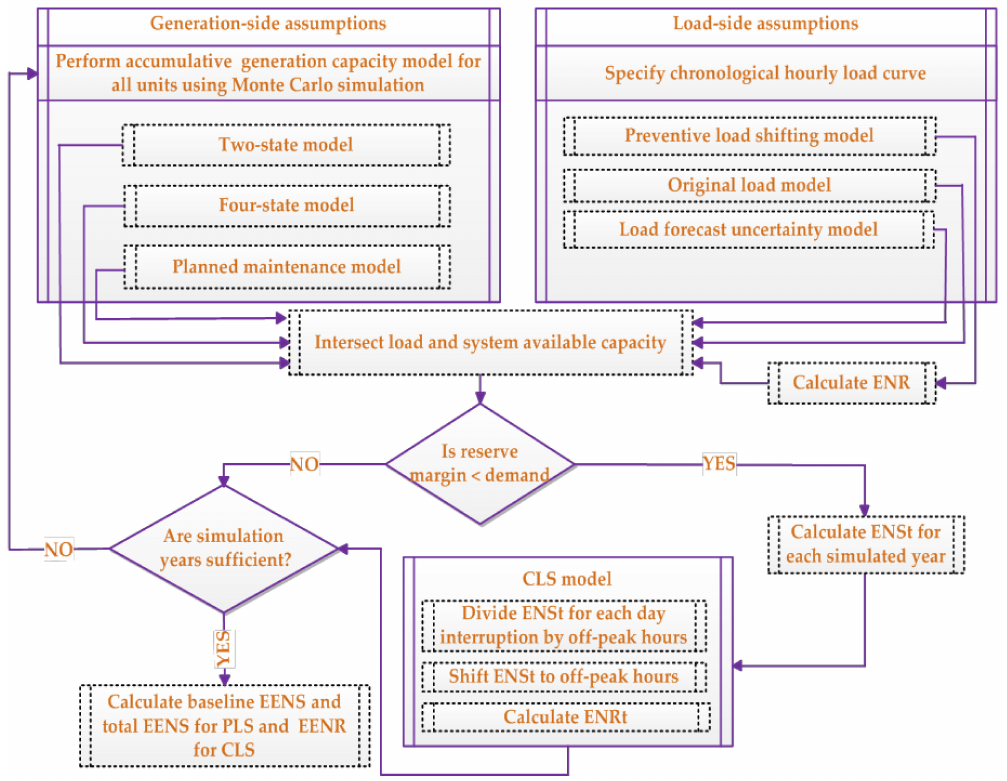
Figure 9. Flow chart of PLS and